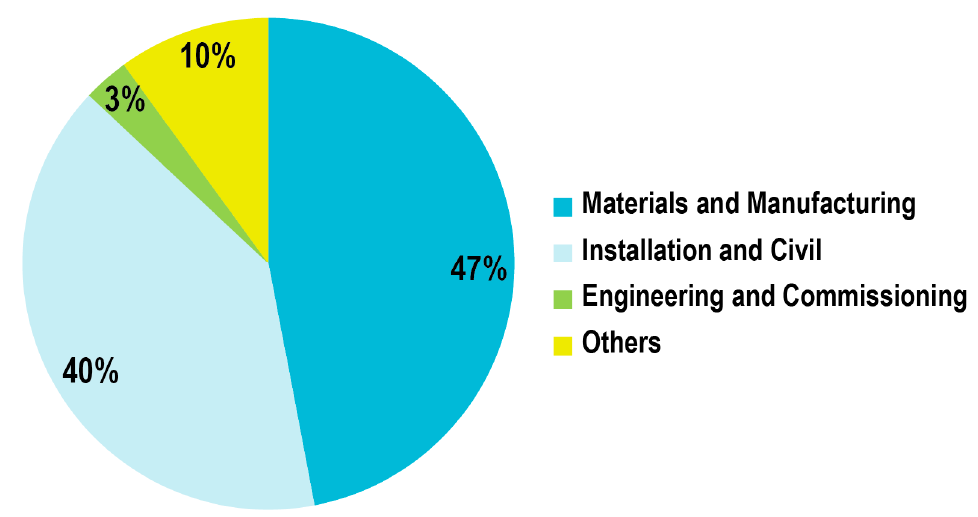
Figure 1. Cost breakdown for subsea cables. Adapted from [6].